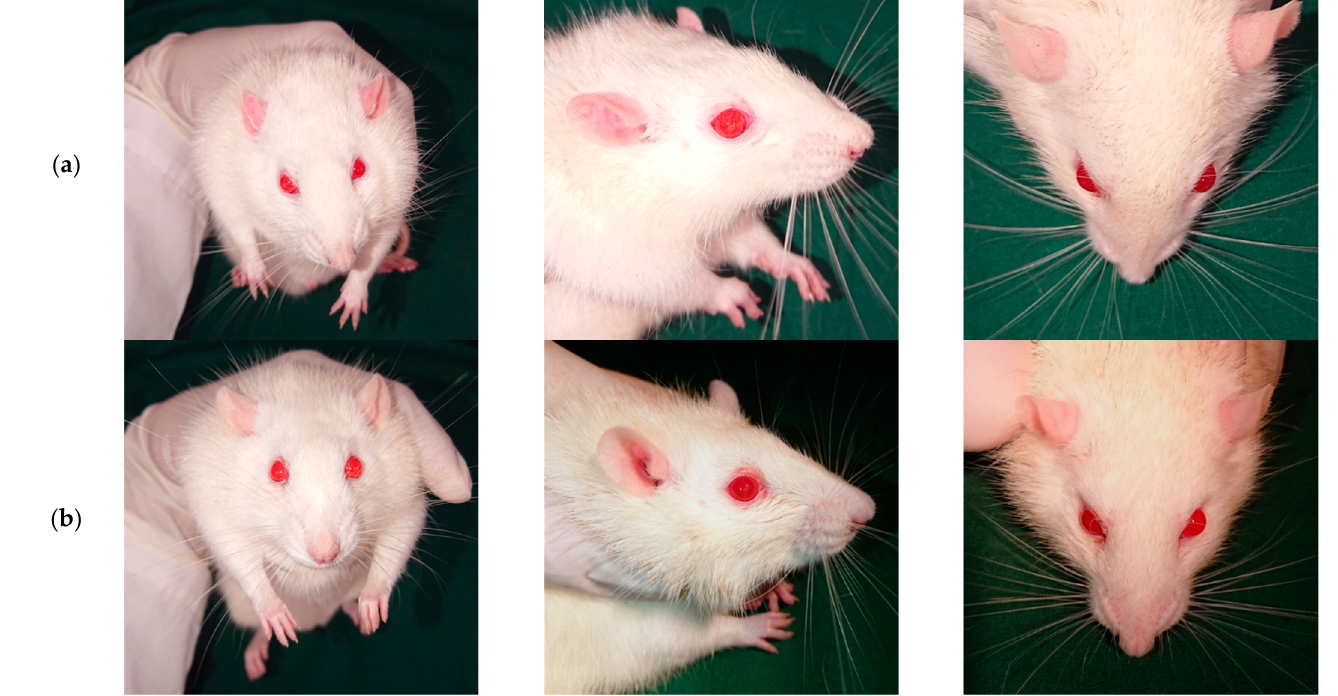
Figure 1. Pictures of a rat 1 h ( a ) and 3 days ( b ) after the cauterization of the 3 episcleral veins of the OD. The animal shows symmetry between both ocular globes and no signs of ocular discomfort.